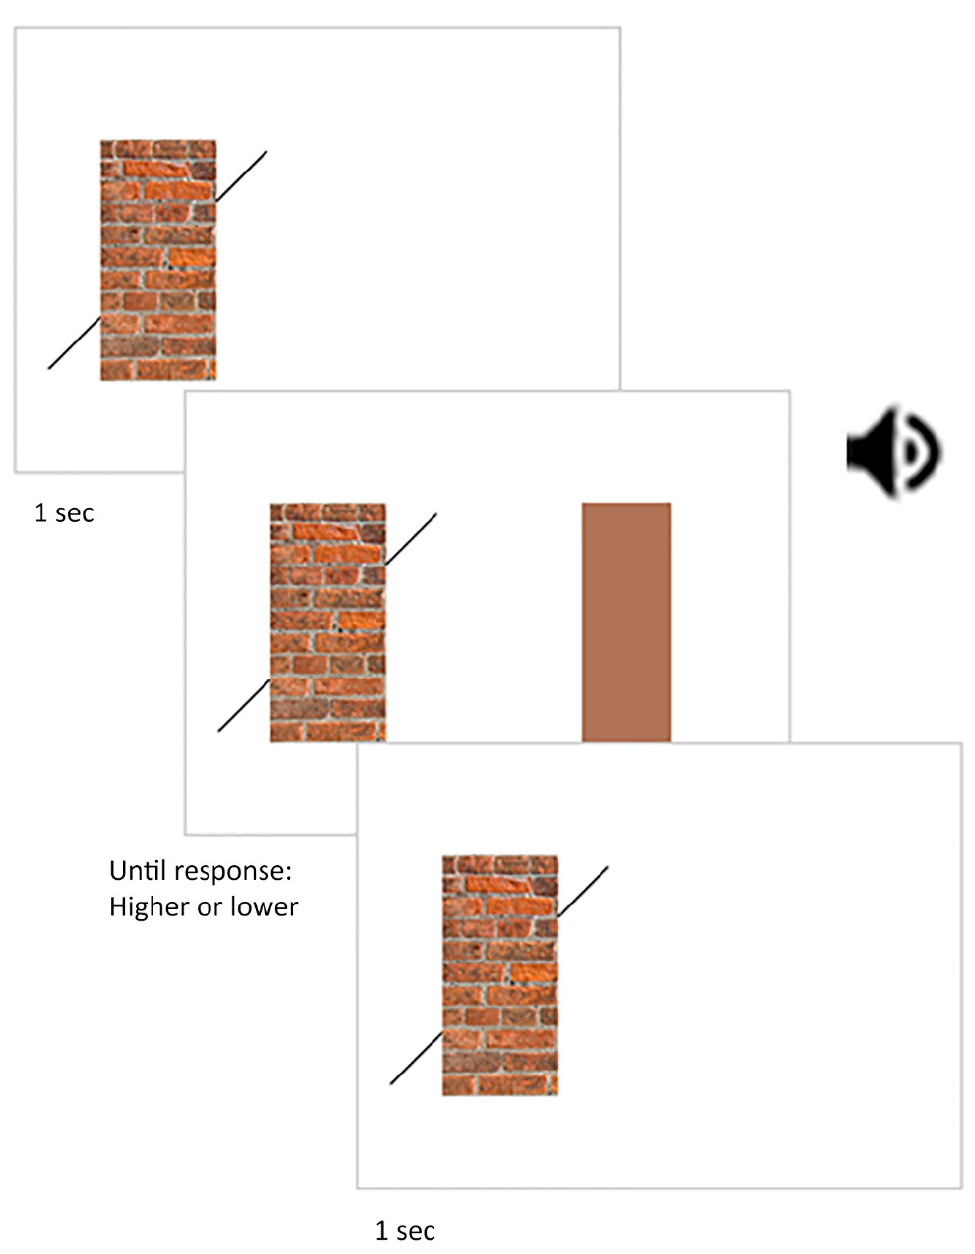
Figure 4. Stimuli and procedures used in experiment 2. In experiment 2, a Poggendorff stimulus with oblique lines was shown for 1 s, followed by an alerting sound cue that signalled the presentation of the comparison rectangle. The participant was required to indicate whether the latter was wider or thinner than the former. The speaker symbol denotes when the auditory alerting cue was presented. During each block, the Poggendorff stimulus on the left was always displayed. A trial began with a one-second delay (Figure 4). After this delay, an auditory beep was accompanied by the presentation of the comparison rectangle. The comparison rectangle was displayed until participants pressed a button on their keyboard to report whether it was wider or narrower than the central rectangle or the gap corresponding to the missing central rectangle in the Poggendorff stimulus on the left. The comparison rectangle disappeared after the button was pressed. A self-paced break was provided at the end of each